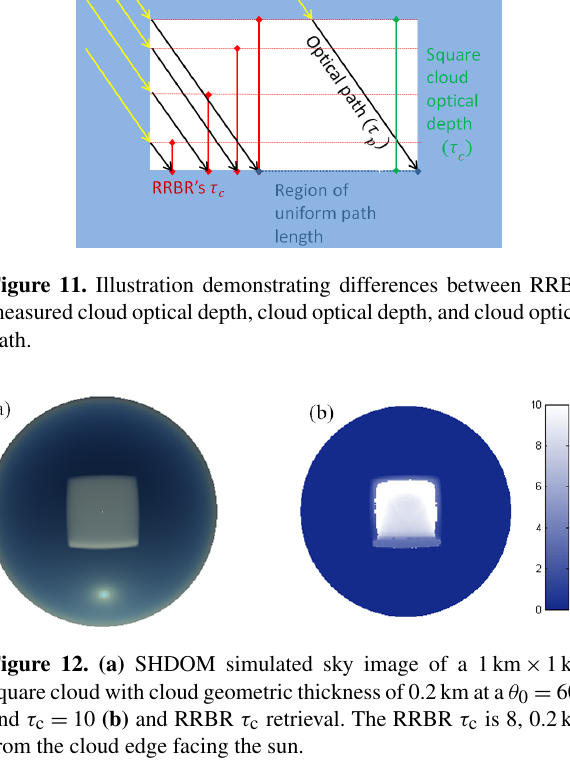
ered locally homogeneous will be left for future work. When horizontal photon transport is included it would be expected to decrease the area of